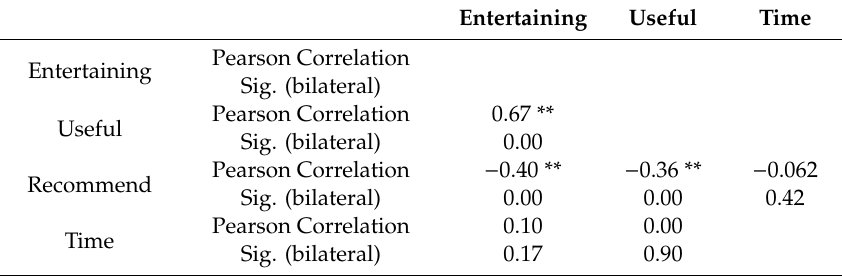
Table 5. Correlations between the time spent playing video games and ratings of Stigma Stop’s entertainment and